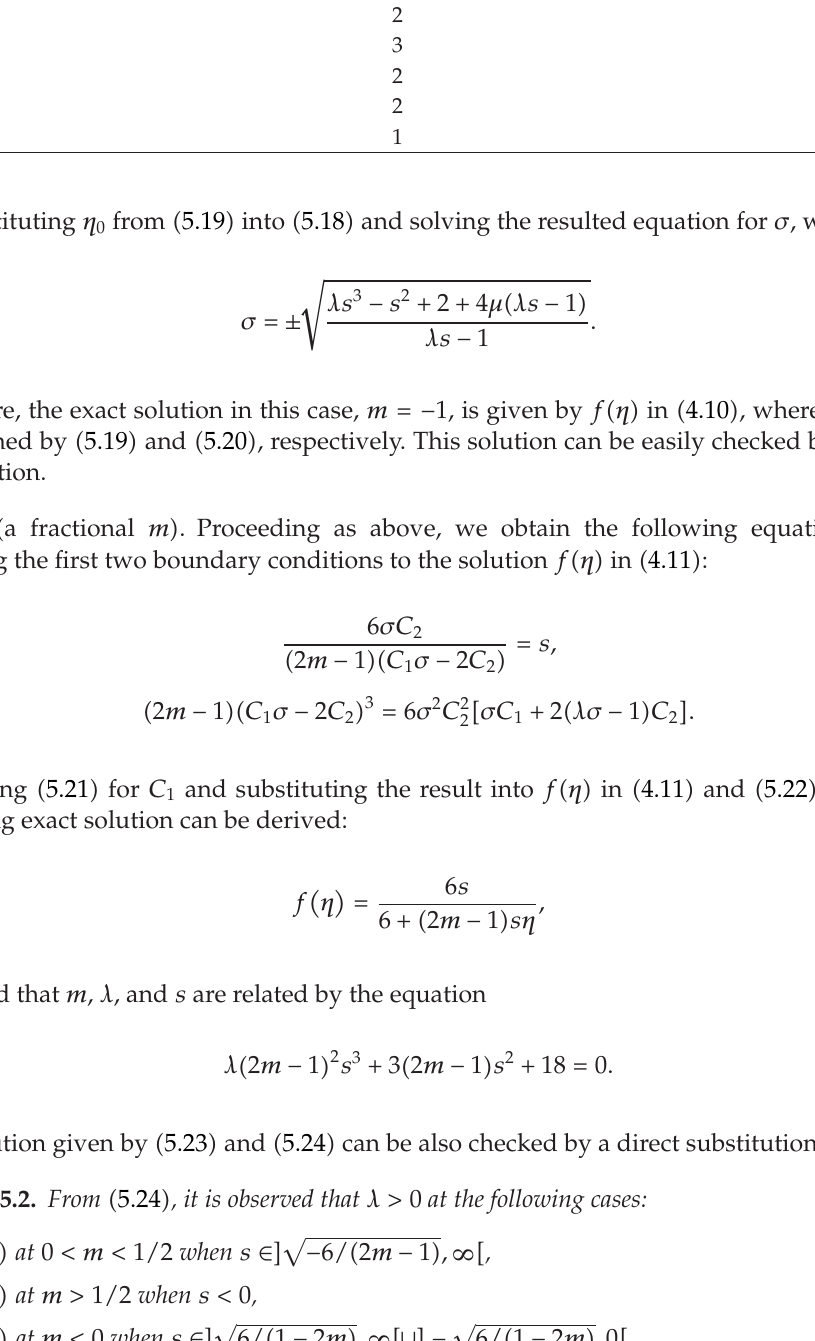
Table 1: Some values of λ and s with their singularities in R 3 . λ s η singular